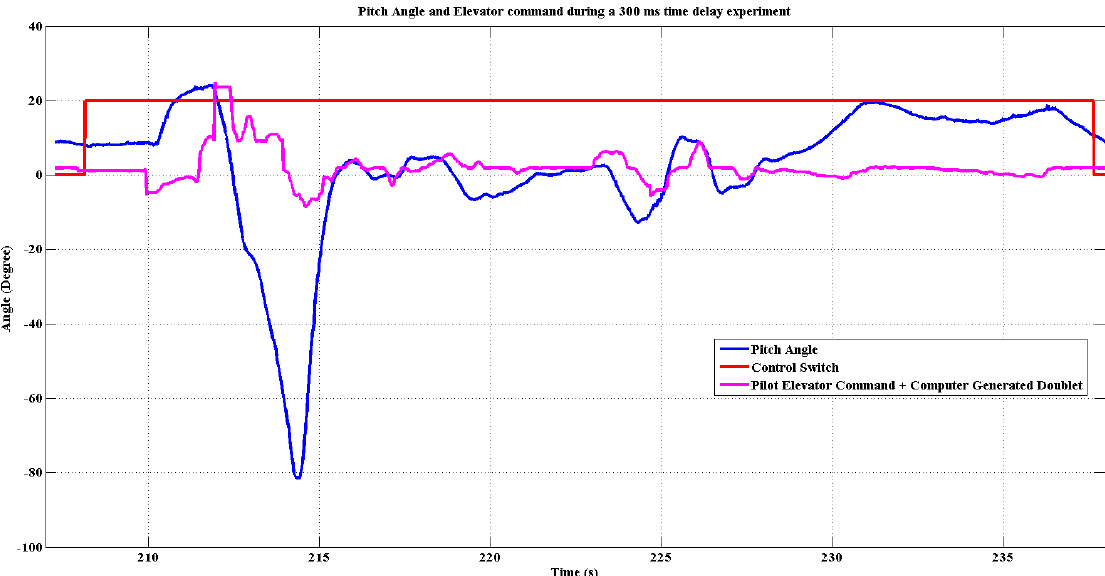
Figure 15. Pitch Angle and Elevator deflection during flight experiment for 300 ms induced delay.